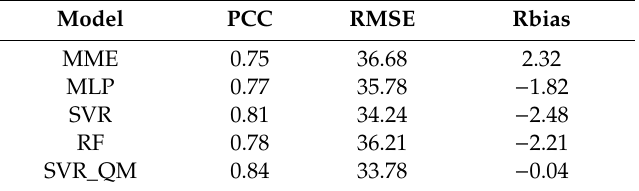
Table 8. Comparison of MME, MLP, SVR, RF, and SVR_QM for the region mean.